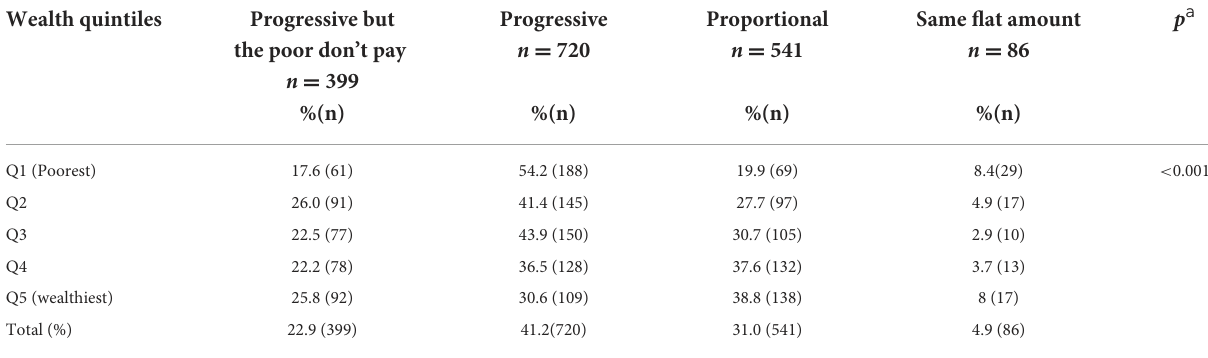
TABLE 3 Payment Preference and wealth quintiles of the respondents. Wealth